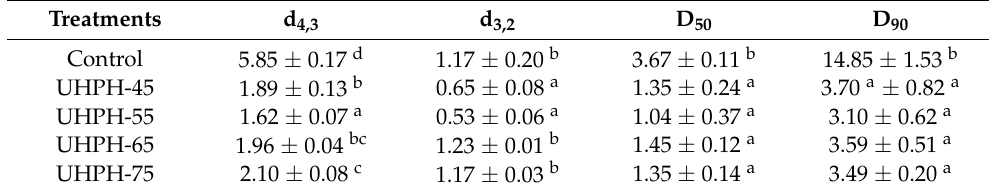
Table 2. Particle size parameters (d 4,3 , d 3,2 , D 50 , and D 90 ) of untreated (control) and ultra-high-